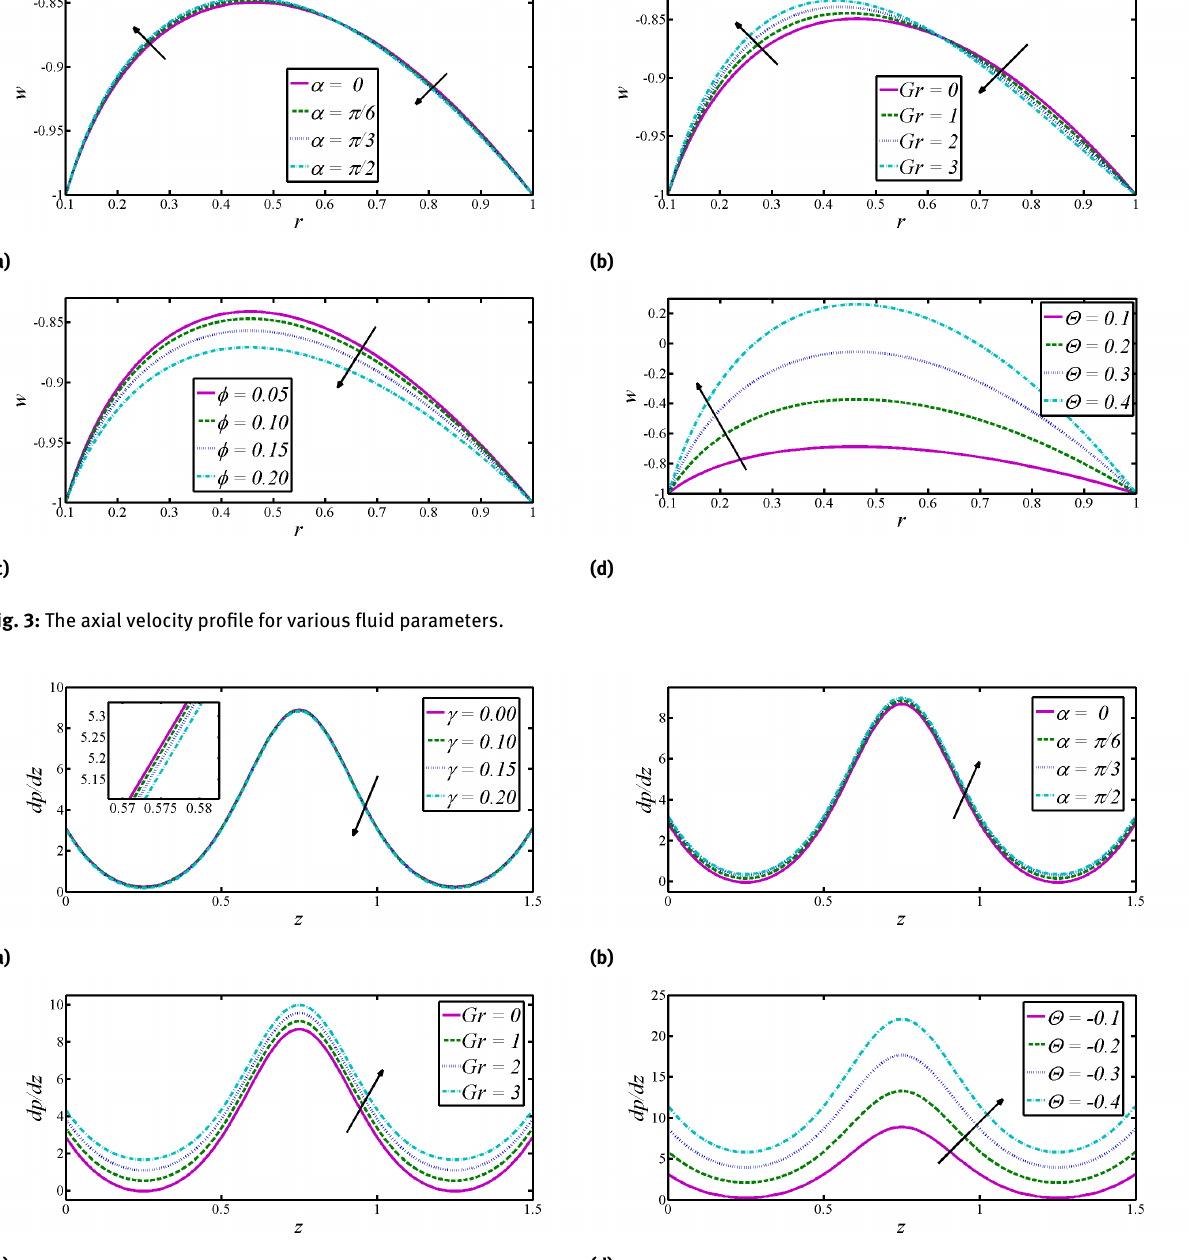
is obtained. The effect of heat transfer and couple stresses on the flow variables is analyzed. The pressure difference and frictional forces have been calculated